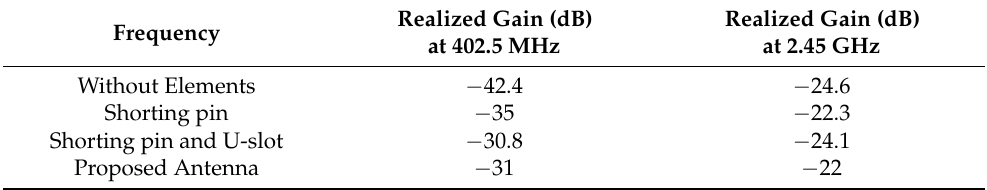
Table 2. Results of maximum Realized Antenna Gain extracted from simulations. Realized Gain (dB) Frequency at 402.5 MHz